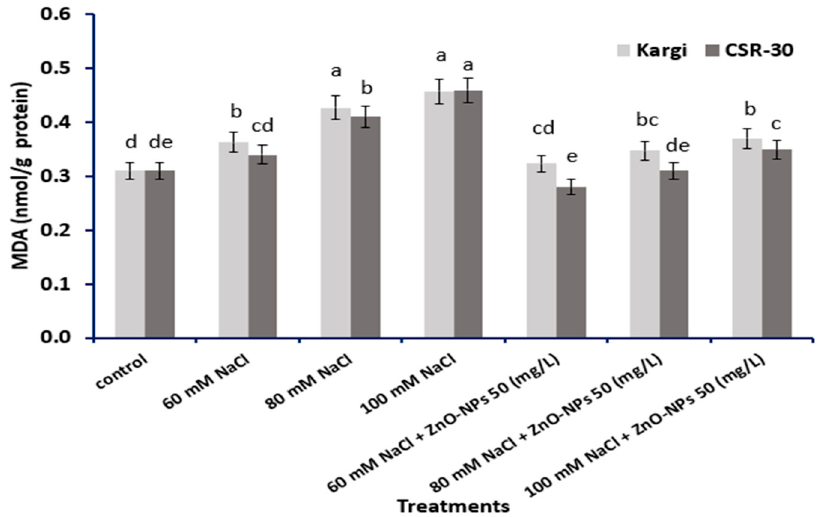
Figure 4 . Impact of ZnO-NPs on MDA content in leaves of Kargi and CSR 30 Oryza sativa genotype in control and under saline conditions. Values are means of three replicates; a statistically significant difference between treatments compared with control is indicated by different small alphabets (a–e). Error bars indicate the least considerable value (LSD) at p ≤ 0.01 among the